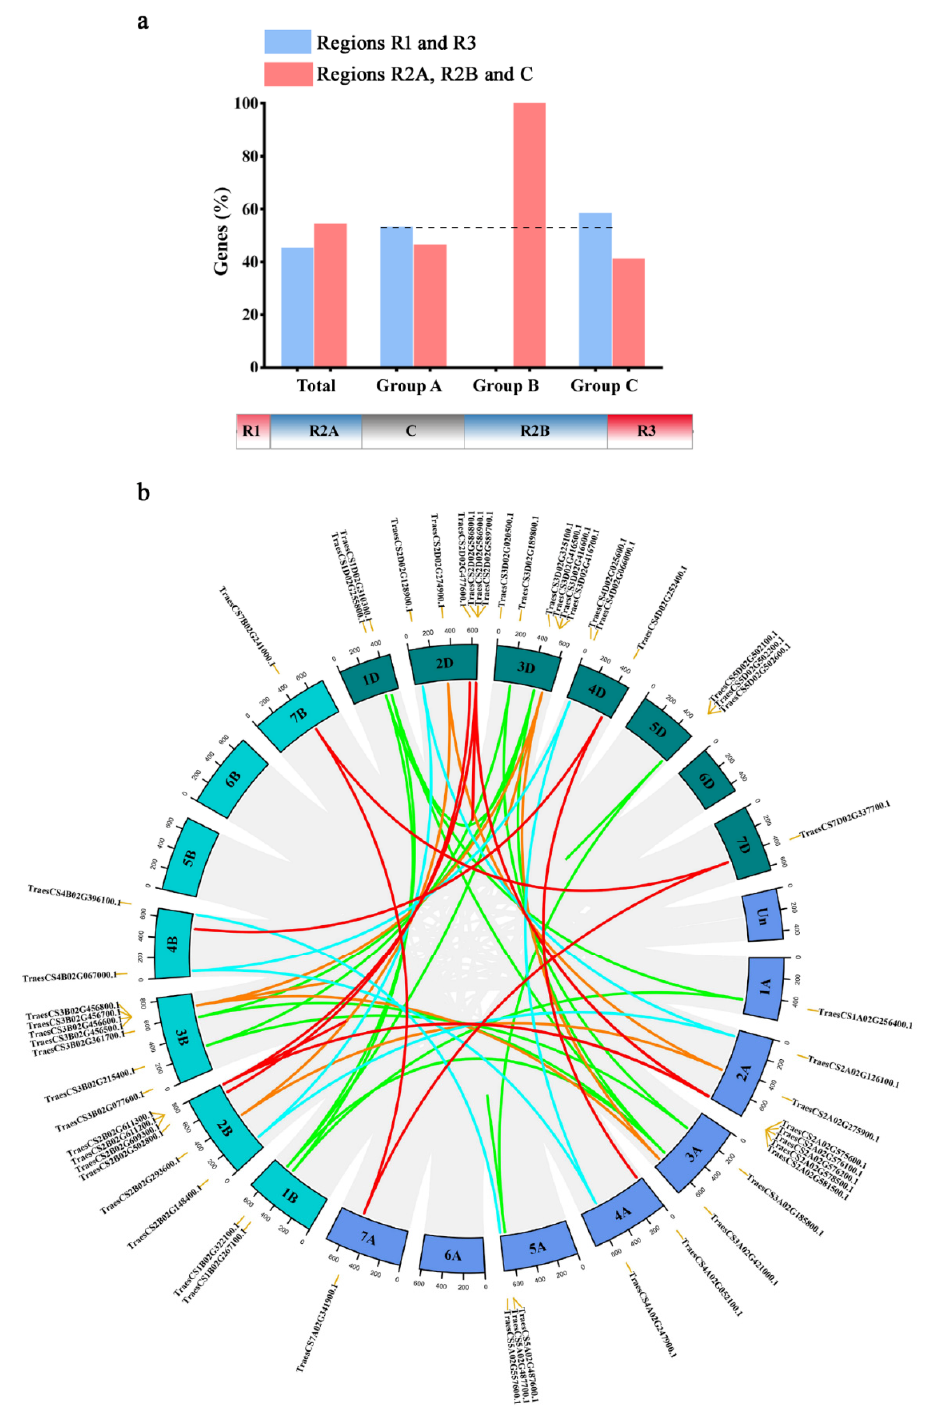
Figure 3. Chromosomal distribution of the TaCystatin family. ( a ) The ratio between the TaCystatin genes in R2A, R2B together with C segments of every chromosome, and R1 together with R3 segments of every chromosome. ( b ) Genomic location and duplication events analysis of 55 TaCystatin genes. Light-gray lines in the background indicate the synteny blocks within the bread wheat genome. The duplication events are highlighted with different colored